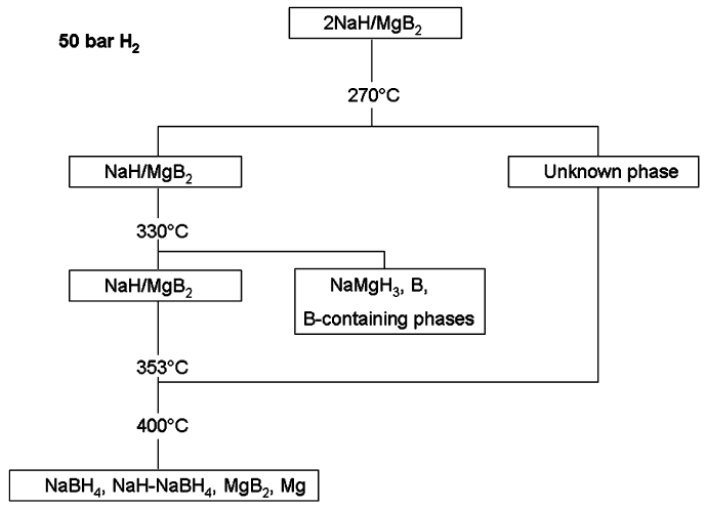
Figure 6. Scheme of the 2NaH + MgB 2 absorption reaction performed under 50 bar H 2 [50]. Reprinted with permission from [50], copyright 2010 The American Chemical